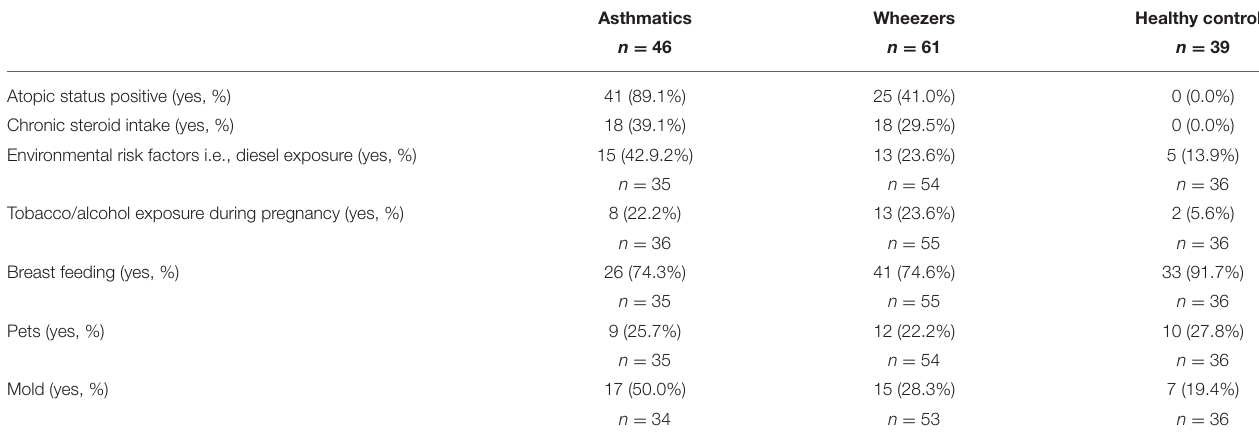
TABLE 1 | Clinical item parameters of samples used for this approach. Asthmatics Wheezers Healthy